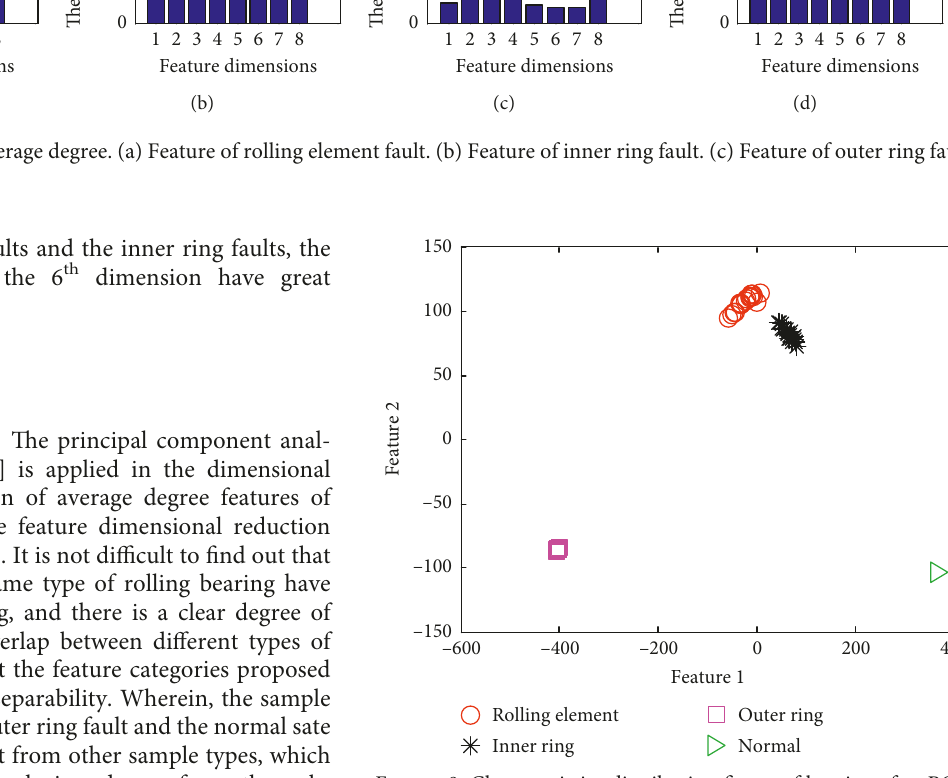
Figure 8: Characteristics distribution figure of bearing after PCA.